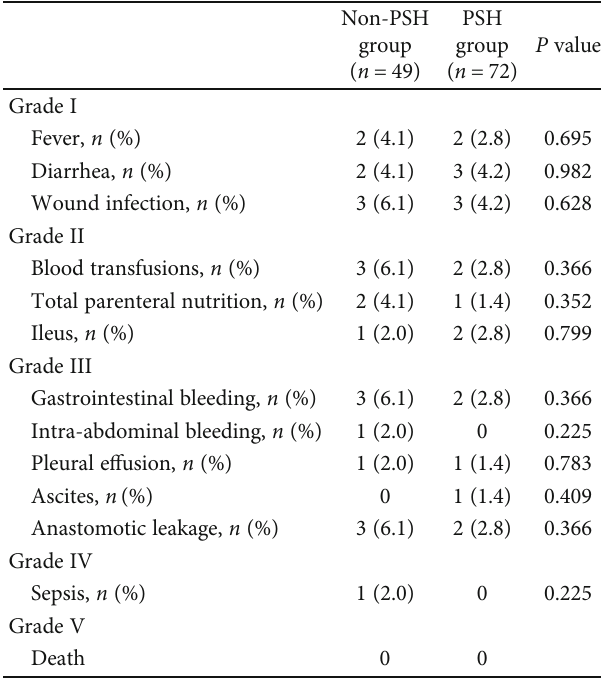
Table 3: Postoperative complication status in patient cohorts (Clavien-Dindo grading system).